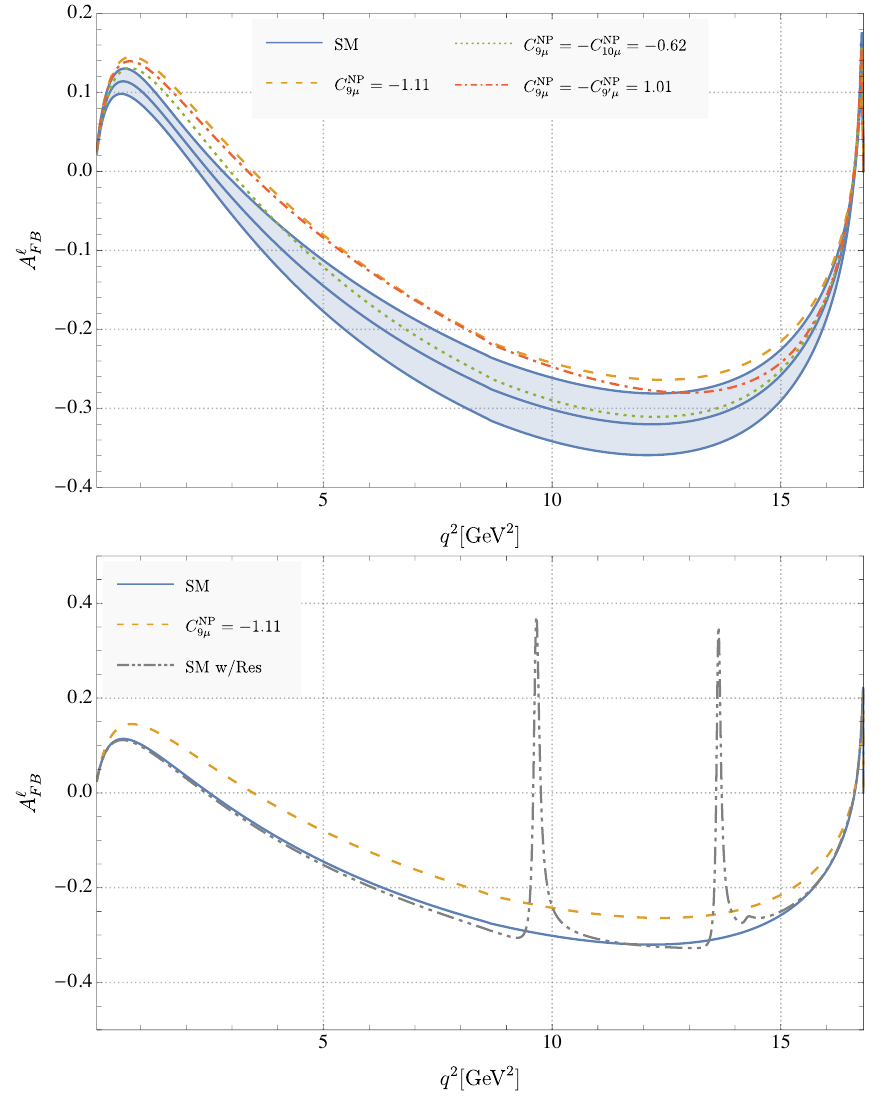
Figure 2 . Top: A ‘ in the SM case and three NP scenarios. Only short-distance contributions FB from charm loops are include. Bottom: For illustration only, we also show the e(cid:11)ect of a model for charmonium resonances in the SM case